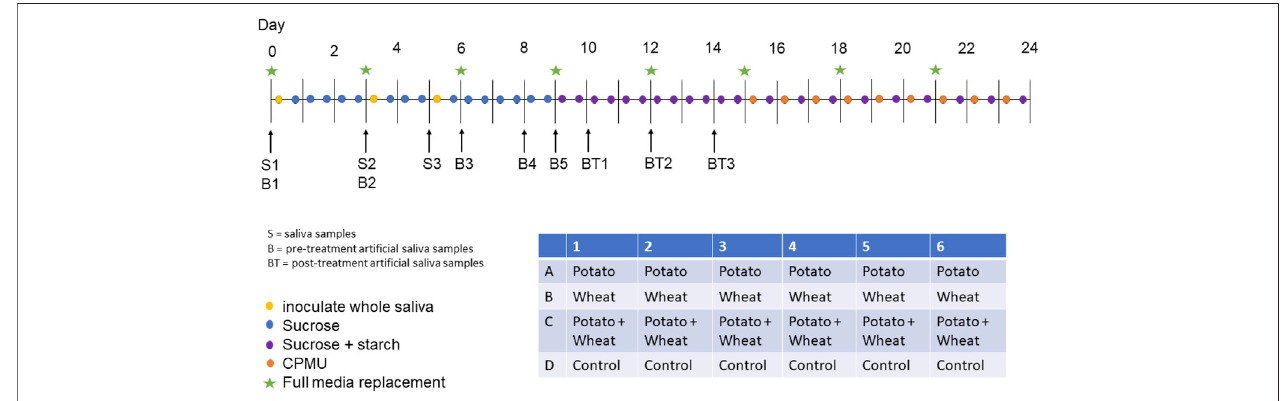
FIGURE 1 | Overview of experiment protocol including the plate